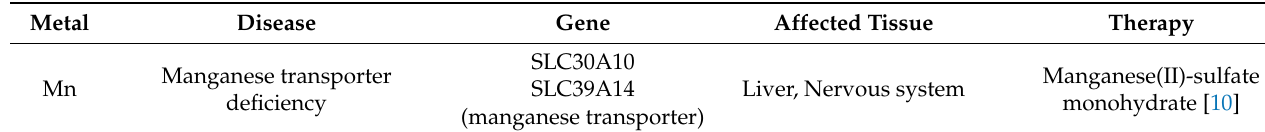
Table 1. Causes and pharmacological therapy in metal-related genetic